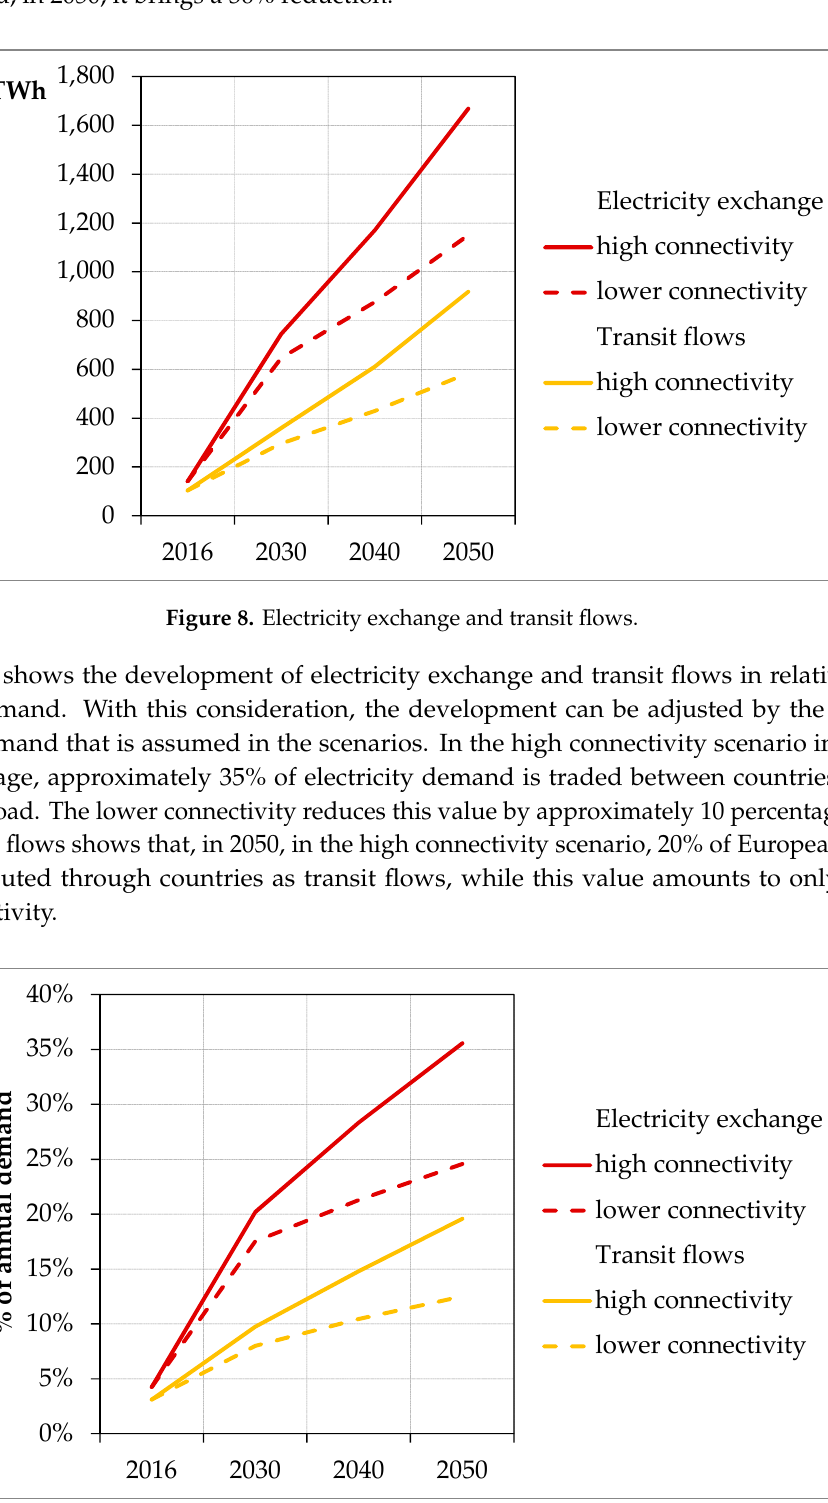
Figure 9. Electricity exchange and transit flows in relation to electricity demand.